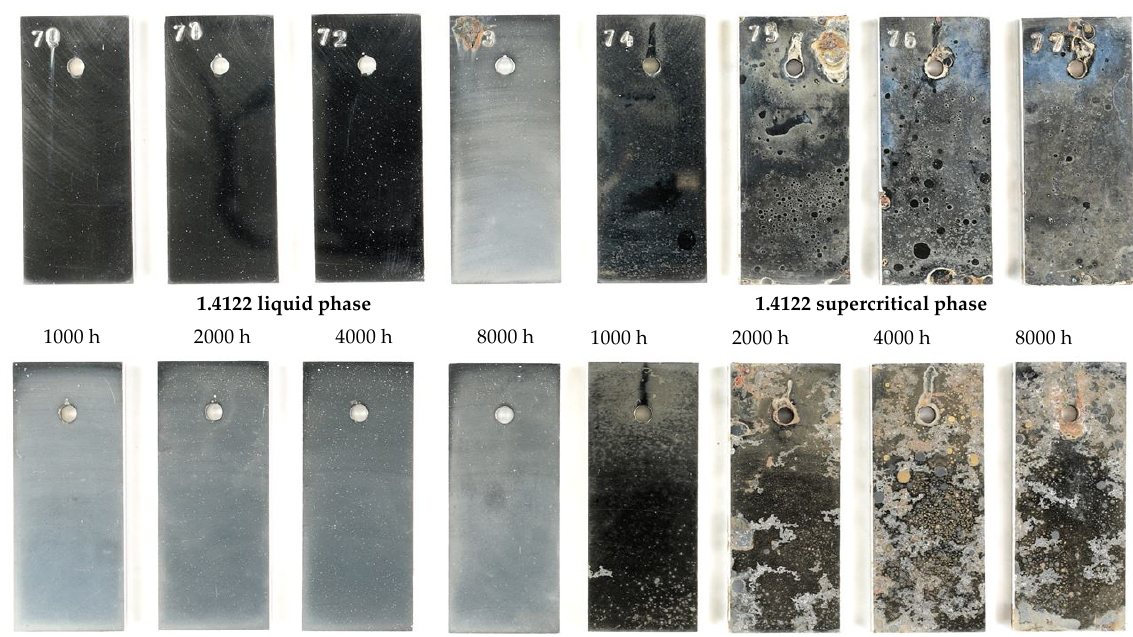
Figure 5. Surface images of X35CrMo17 after 1000 to 8000 h of exposure to CO 2 –saturated aquifer water at 60 °C and 100 bar.